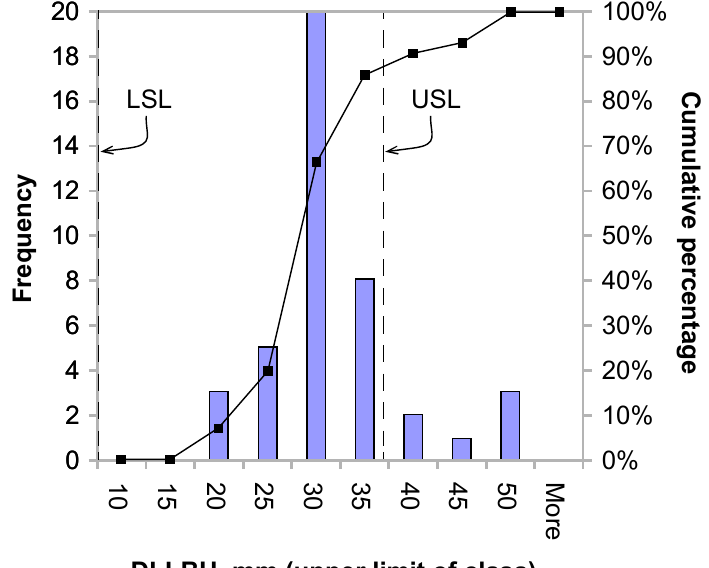
Figure 8. Frequency of DLLBH (diameter of largest limb at breast height) and conformance to a 35 mm upper specification limit for one plot at the Twin Peaks field trial (Initial Stems per Acre (ISPA) with Repeated Thinning (RT) and Fertilization (F); vertical dotted lines represent LSL (lower specification limits) and USL (upper specification limits) for DLLBH (adapted from